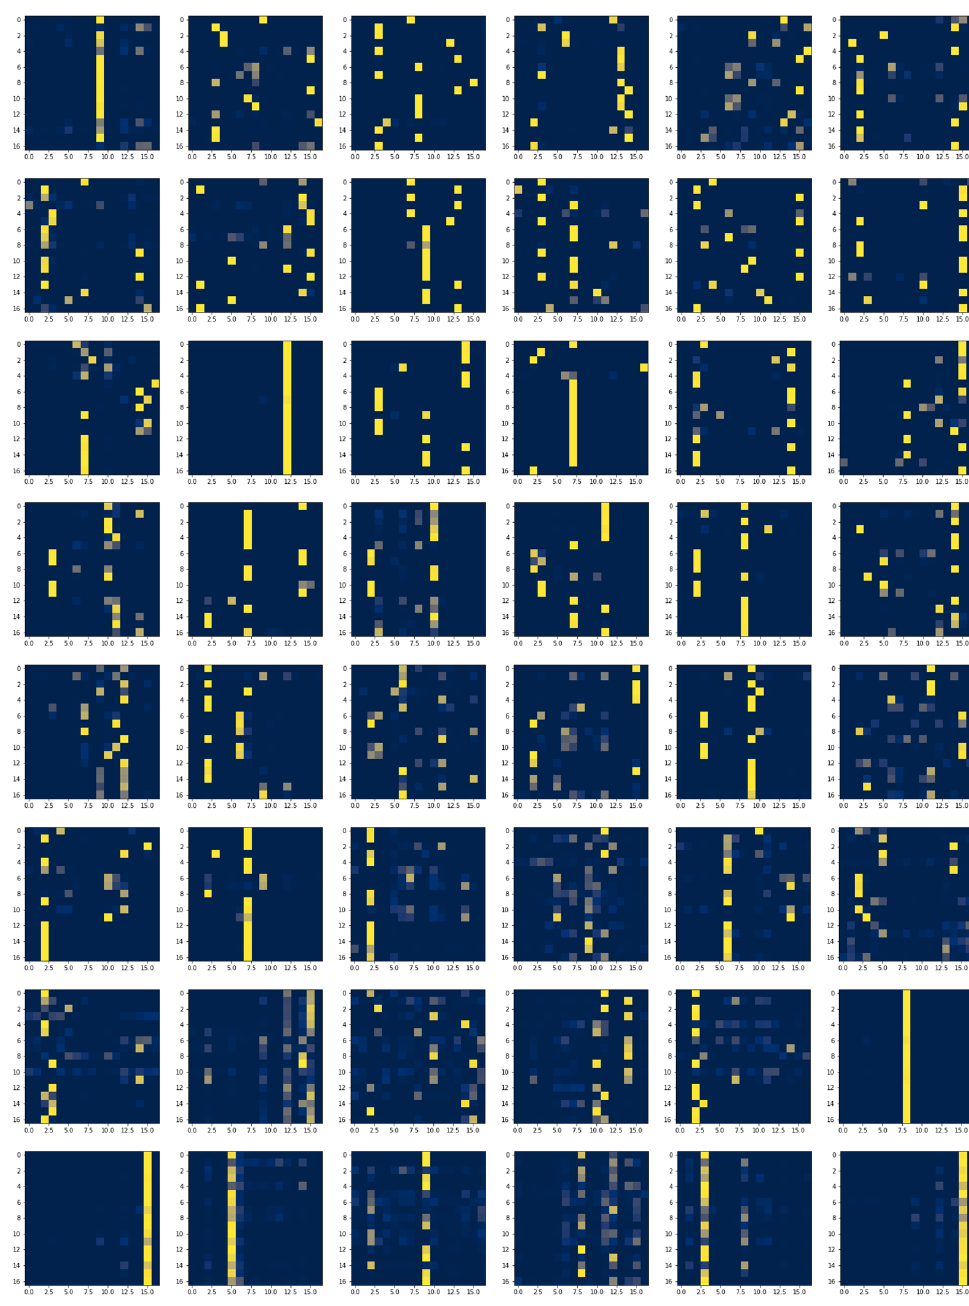
Figure A1. The attention maps for a random AD fMRI slice from the testing set in AD vs. HC vs. MCI in OViTAD with head = 8 and depth = 6, input dimension =